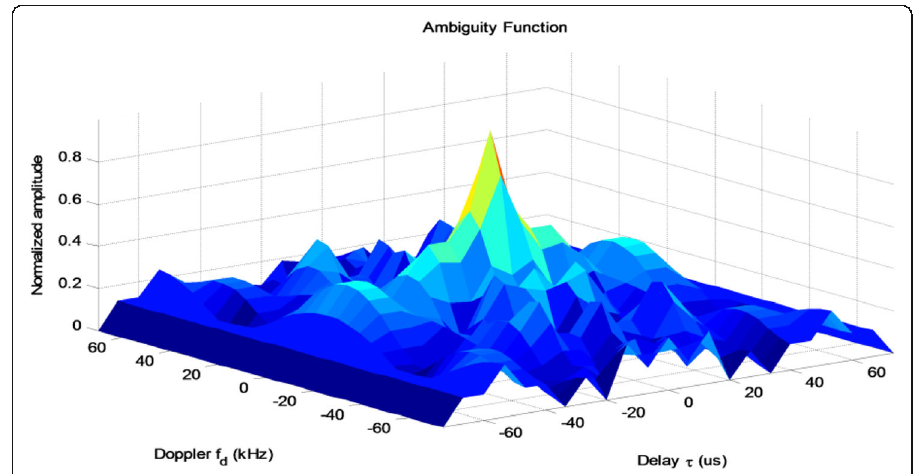
Fig. 2 Ambiguity function of Barker code